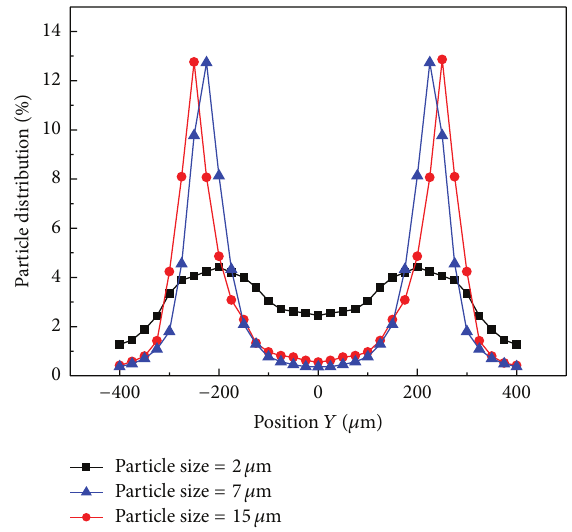
Figure 7: Particle contribution in various flow rates (with particle size being 7 𝜇 m).